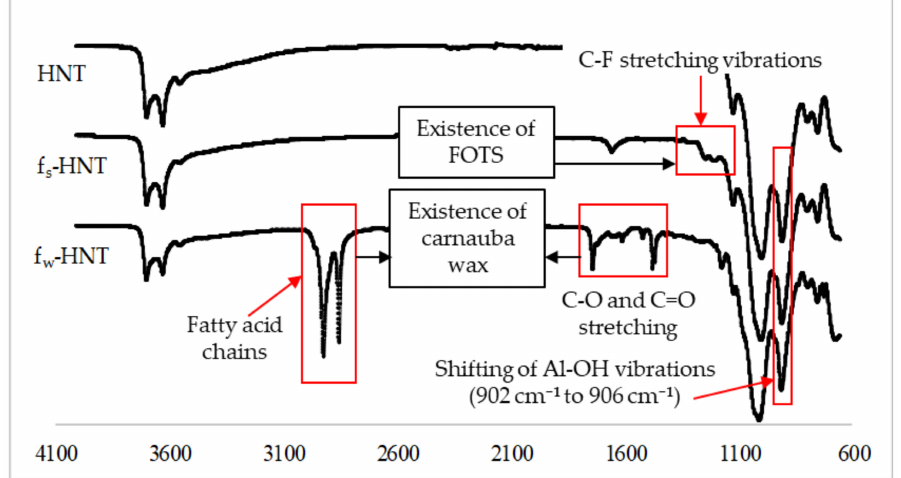
Figure 6. New functional groups of functionalized HNT particles using FOTS and carnauba wax. Carnauba wax functionalization shows a significant peak along the HNT